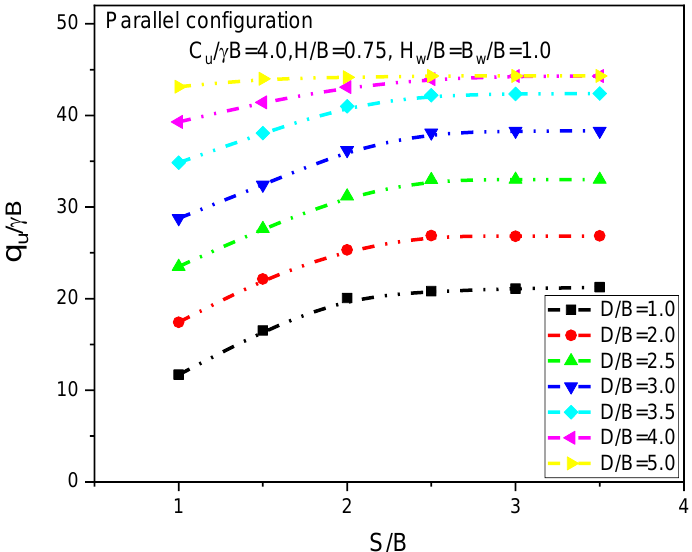
Figure 11. Effect of the parallel configuration on the ultimate bearing capacity ratio qu/γB (two voids).